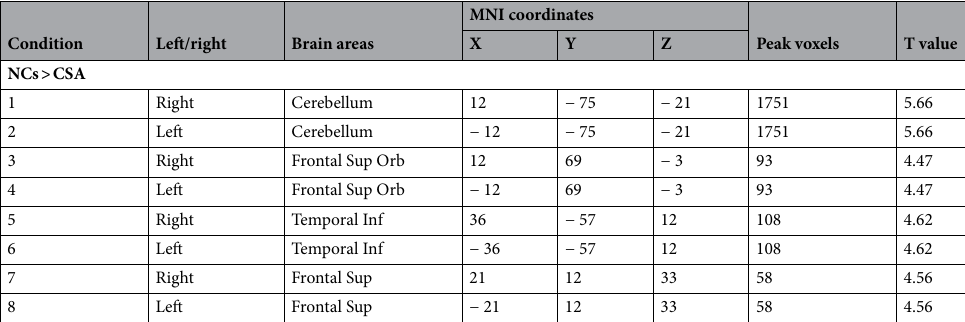
Table 2. Brain areas demonstrated significantly different VMHC values between CSA and NC group. Notes: The statistical threshold was set at voxel level with P < 0.05 for multiple comparisons using Gaussian random field theory voxels with P < 0.01 and cluster size > 40 voxels, Alphasim corrected. VMHC Voxel-mirrored homotopic connectivity, CSA children with strabismus and amblyopia, NCs normal controls, BA Brodmann area, MNI Montreal Neurological Institute.